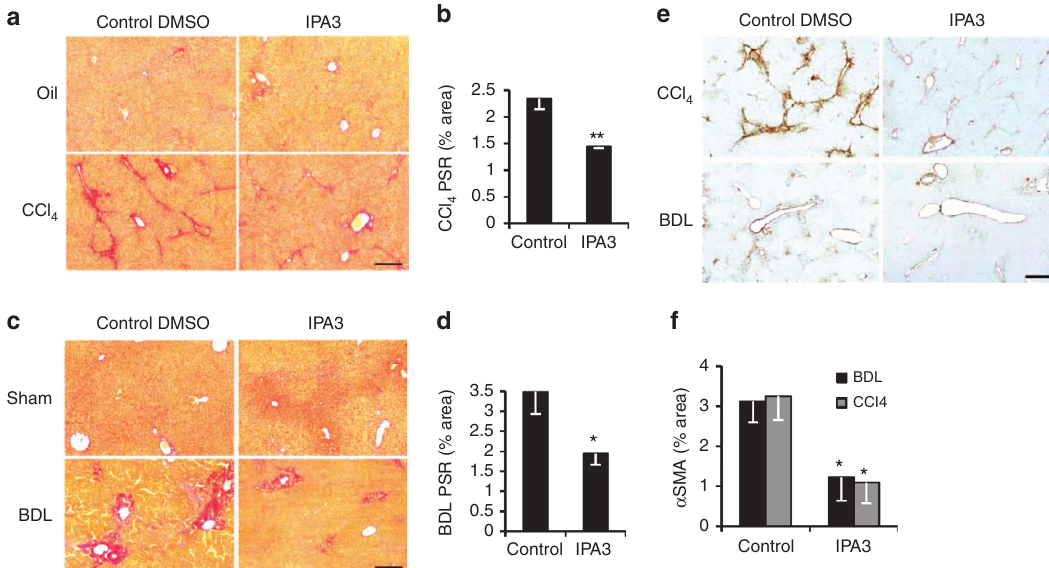
Figure 6 | Pharmacological inhibition of PAK-1 improves liver fibrosis in rodents. ( a ) PSR staining (collagen deposition in red) in olive oil control (Oil; top) or chronic CCl 4 -induced fibrosis (bottom) with DMSO ( n ¼ 5) or IPA3 ( n ¼ 4) treatment. ( b ) Quantification of surface area covered by the PSR staining in a . ( c ) PSR staining (collagen deposition in red) in sham-operated mice (Sham; top) or BDL to induce peribiliary fibrosis (bottom) with control DMSO ( n ¼ 6) or IPA3 ( n ¼ 7) treatment. ( d ) Quantification of surface area covered by the PSR staining in c . ( e ) Immunohistochemistry for a -SMA (brown; activated HSC/myofibroblast marker) in mouse livers following CCl 4 (top) or BDL (bottom) induced fibrosis. ( f ) Quantification of surface area covered by a -SMA staining was reduced following IPA3 treatment in both models ( n ¼ 5 for all animal groups). Scale bar, 500 m m. Two-tailed unpaired t -test was used for statistical analysis. Data are shown as means ± s.e.m. * P o 0.05, ** P r 0.01.